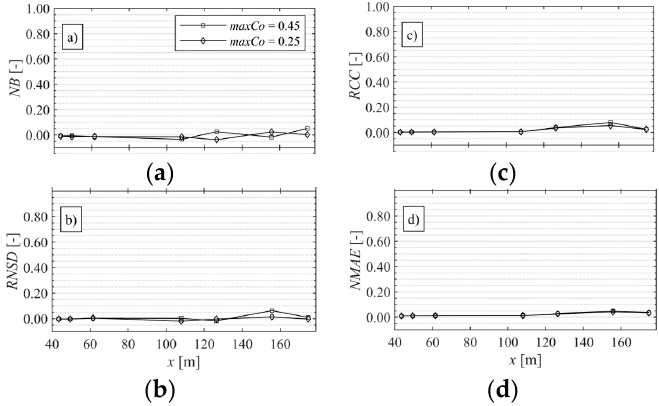
Figure A2. OF model time step convergence analysis based on maxCo for the mesh with β sez = 2. The reference is the lowest maximum Courant number applied ( maxCo = 0.15). See caption of Figure A1 for the description of ( a–d ).